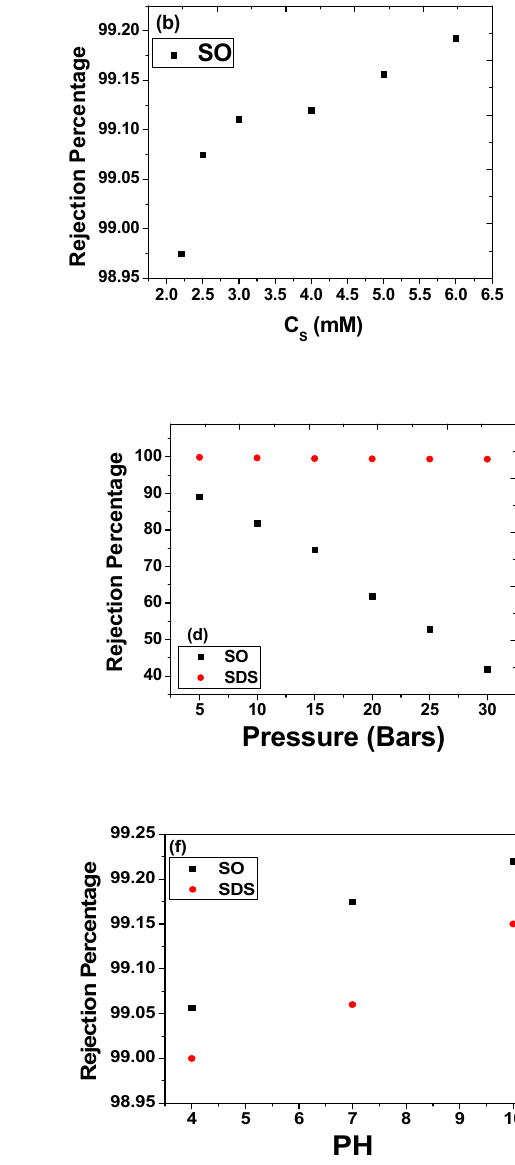
Figure 4. Rejection percentage (R%) of ( a ) SDS concentration (C SDS ), ( b ) SO concentration (C SO ), ( c ) electrolyte concentration (NaCl) of SDS and SO, ( d ) pressure, ( e ) RPM, ( f )